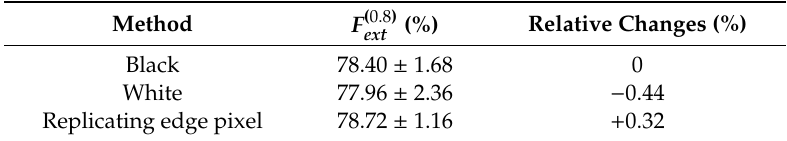
mode. Twenty original images are used, and the data augmentation factor 𝑓 is 3.